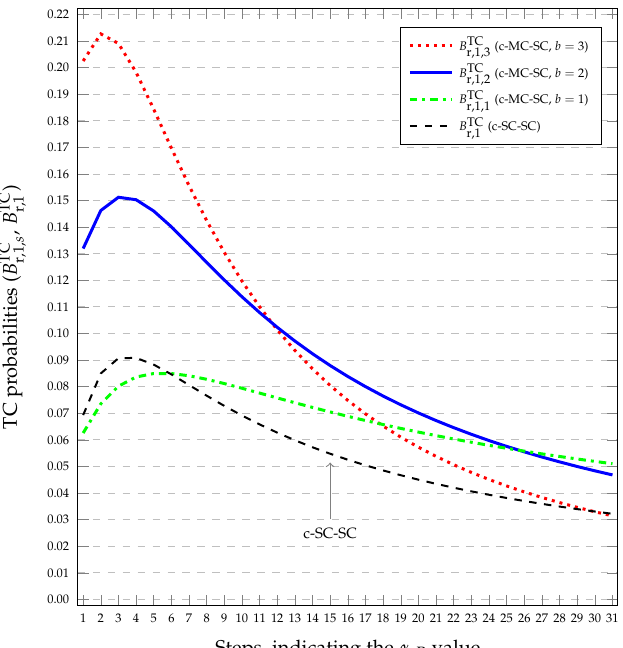
( s = 1,2,3), for all service-classes in the 1st RRH (c-MC-SC vs. r,1, s